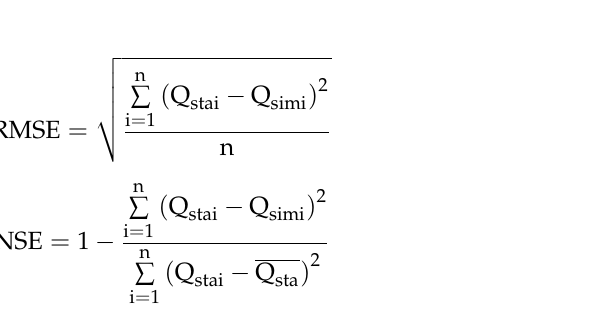
Figure 4. Water yield per unit area of each type of land. On the spatial scale, the spatial distribution of water yield depth in the TGRA from 2005 to 2018 did not vary greatly and showed a consistent distribution across years, with lower water yield depth in the head and tail of the TGRA and higher water yield depth in the belly (Figure 5). The high-value water yield areas from 2005 to 2018 were concentrated in Fengjie County, Kaizhou District, Yunyang County, Wanzhou District, Wuxi County, and Shizhu County in the belly of the TGRA, with the multi-year average water yield in the range of 22.75 × 10 8 m 3 –27.93 × 10 8 m 3 . The low-value areas are concentrated in Jiulongpo, Shapingba, Nanan, Jiangbei, Dadukou, and Yuzhong districts in the tail of the TGRA, with the multi-year average water yield fluctuating between 0.59 × 10 8 m 3 and 2.73 × 10 8 m 3 (Figure 6). In total, 15 districts and counties increased in water yield, though the overall water yield in the TGRA decreased by 1.05%. In addition to the precipitation, ac- tual evapotranspiration, and land use type, the administrative area’s size also affects the